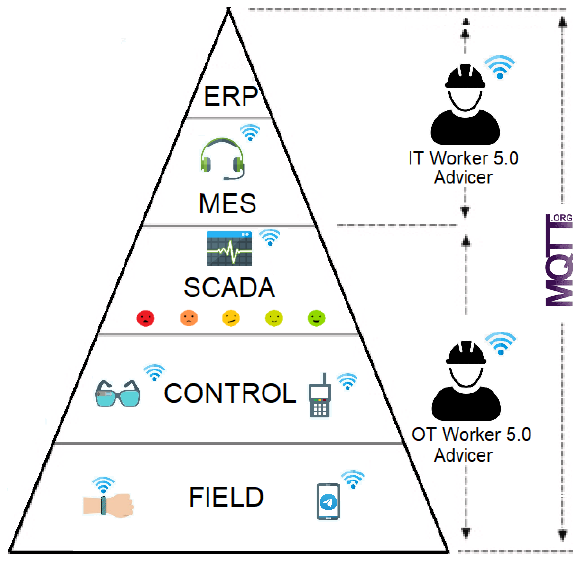
Figure 10. Connected worker 5.0 inside ISA 95.